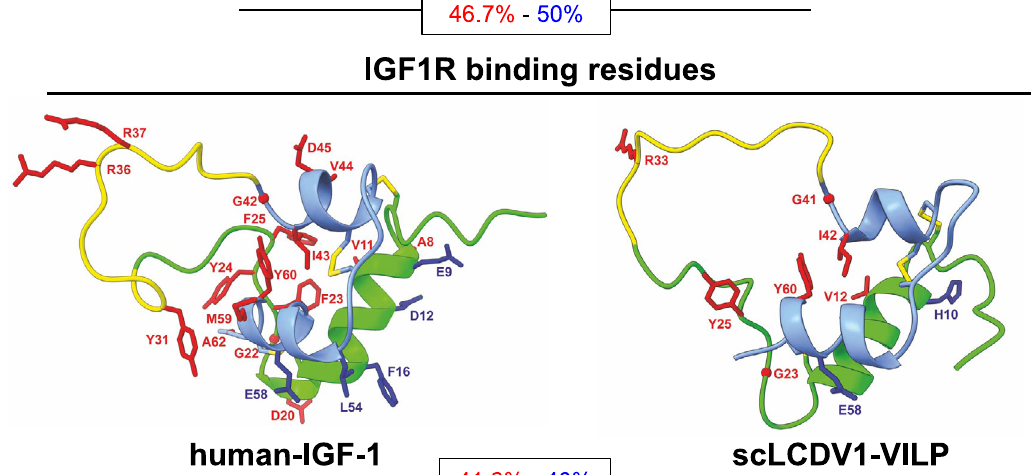
(AlphaFold2 prediction, pLDDT 78.23) and LCDV1-VILP as a single- (sc) and double chain (dc) molecules (AlphaFold2 predictions, pLDDT scores: scLCDV1=71.47, dcLCDV1=80.58). The A- and B-chains are represented in blue and green, respec- tively,andtheC-peptideisinyellow.Residuesinvolvedinbindingtosite1andsite2 of the insulin/IGF-1 receptor are respectively in red and blue. The percentage of conserved binding residues with the sites 1 and 2 are indicated in red and blue,